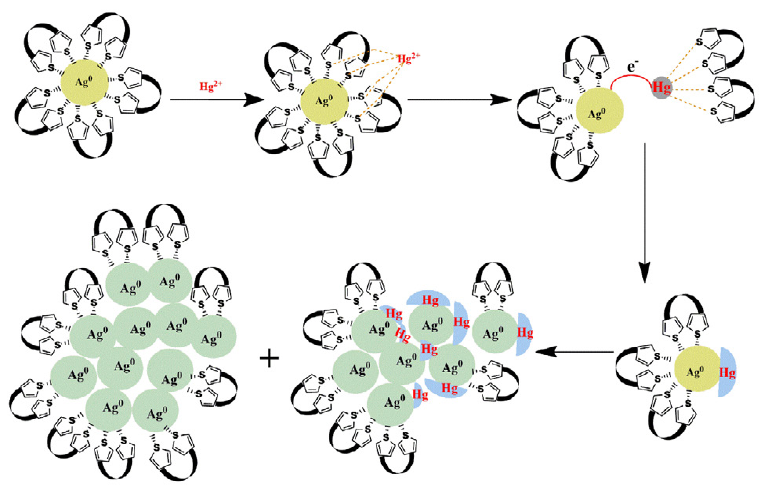
Fig. 13. Proposed mechanistic aspect of Hg 2+ sensing by